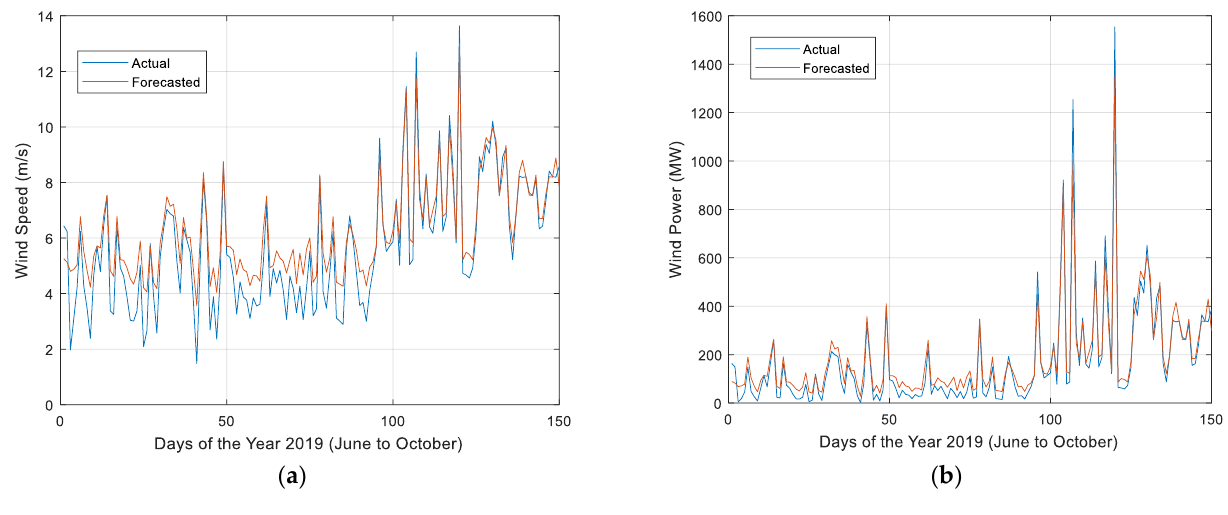
Figure 15. ( a ) Comparative analysis of wind speed forecasting by the CFNN trained through MHPSO-BAAC- χ. ( b ) Comparative analysis of wind power forecasting by the CFNN trained through MHPSO-BAAC- χ.